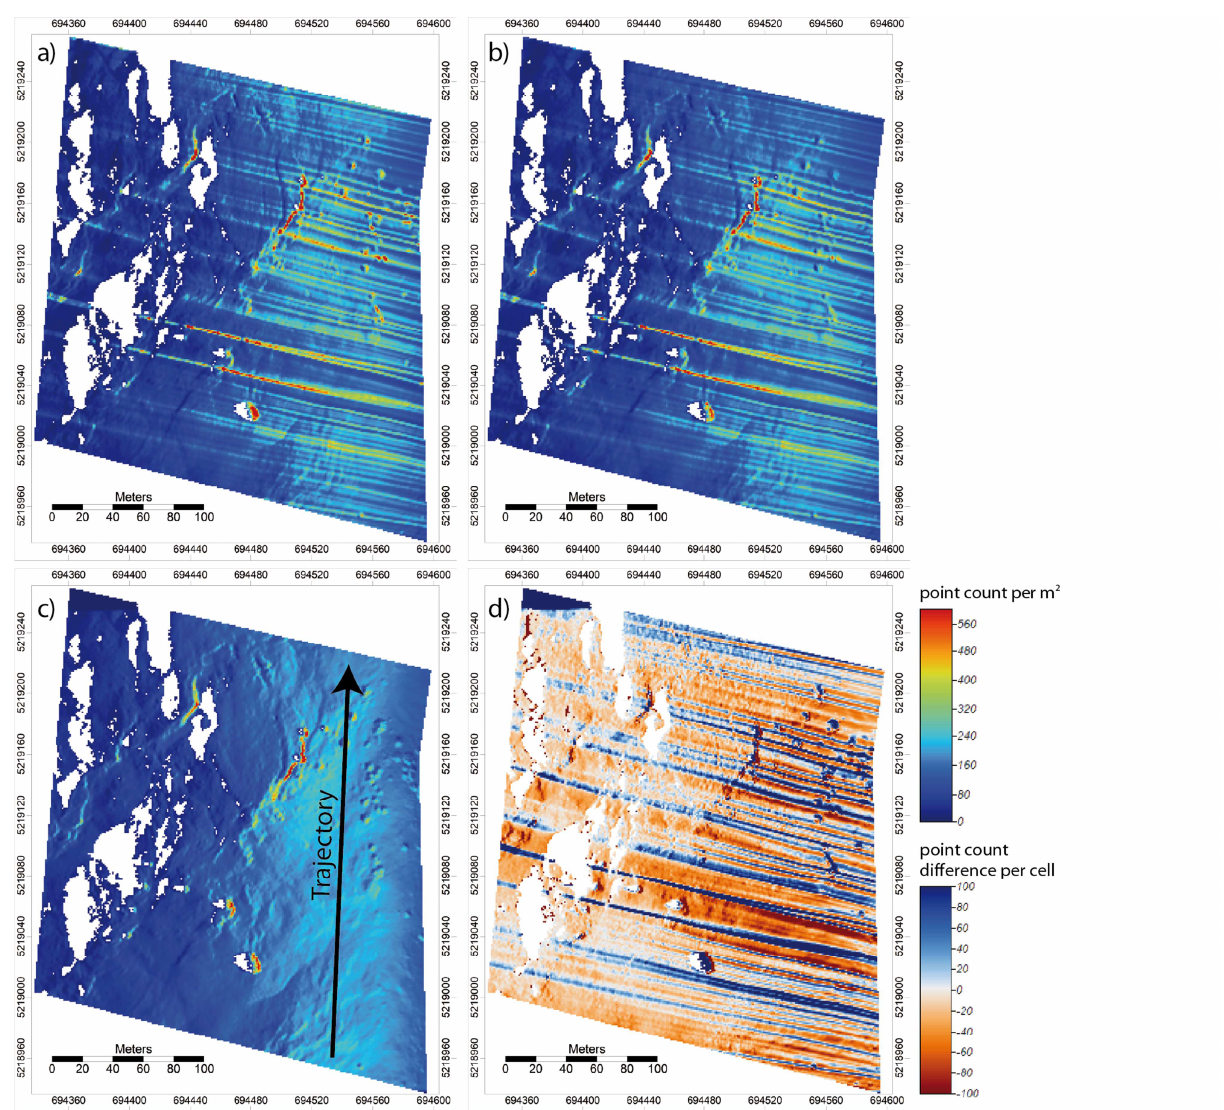
Figure 9. Laser point density and density difference maps for the complex terrain test case: a) real point densities of the acquired point cloud; b) simulated point densities based on flown trajectory with known orientations and positions; c) simulated point densities based on planned trajectory; d) difference between real and simulated (planned) point